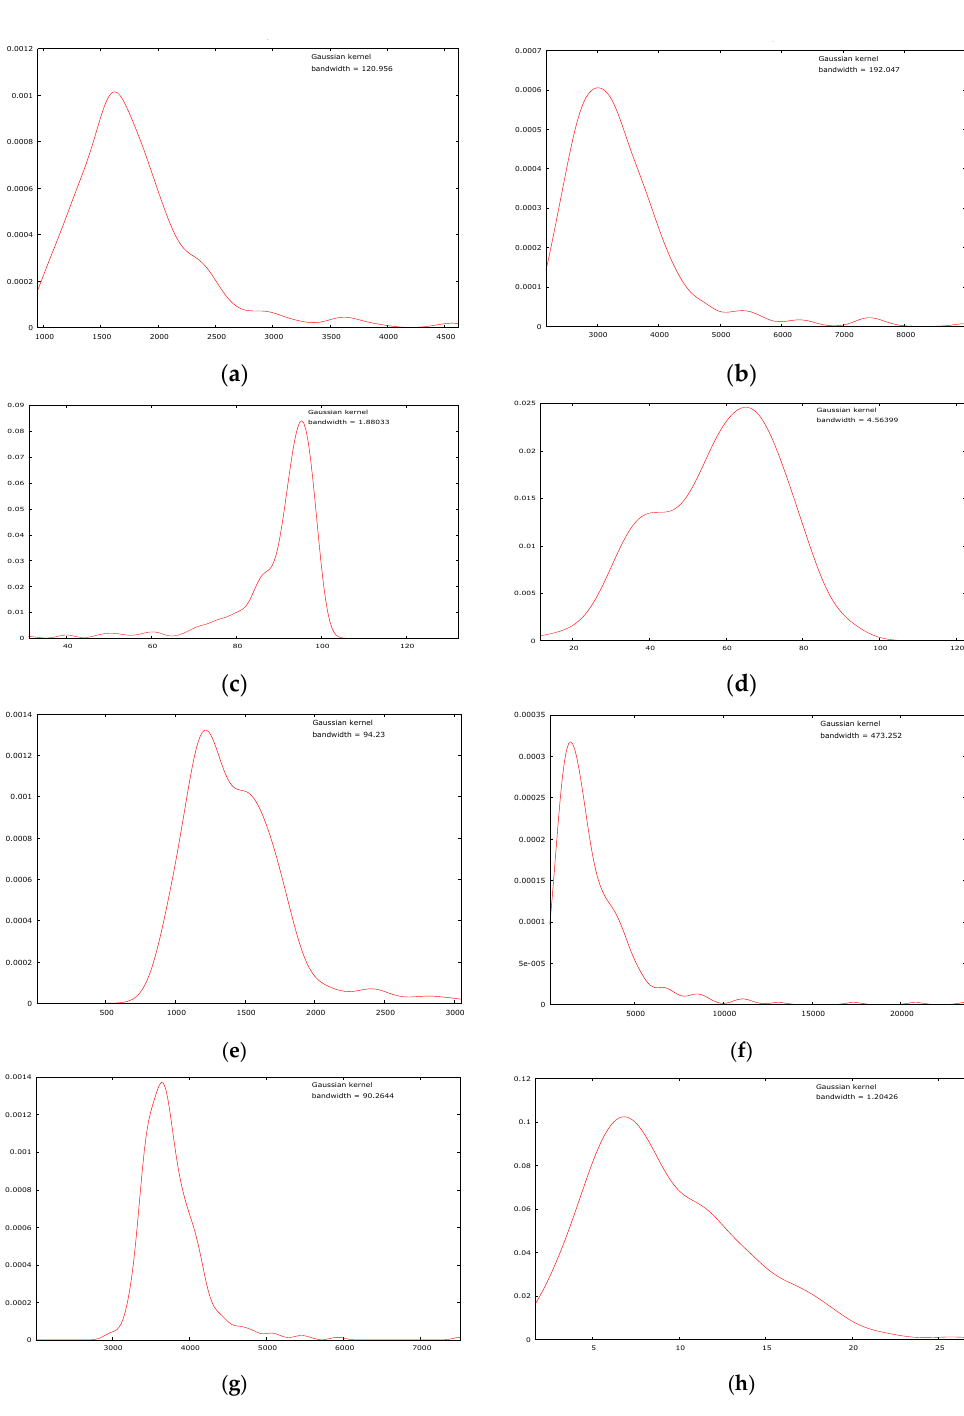
Figure 3. ( a ) Estimated density for the variable x 1 — own revenue of municipal budgets in the district at national level. ( b ) Estimated density for the variable x 2 — population per public pharmacy at national level. ( c ) Estimated density for the variable x 3 — share of population served by water supply at national level. ( d ) Estimated density for the variable x 4 — share of population served by a sewerage network at national level. ( e ) Estimated density for the variable x 5 — entities of the national economy per 10,000 of population in working age at national level. ( f ) Estimated density for the variable x 6 — investment outlays in enterprises per capita at national level. ( g ) Estimated density for the variable x 7 — average monthly gross wages and salaries at national level. ( h ) Estimated density for the variable x 8 — registered unemployment rate at national level.